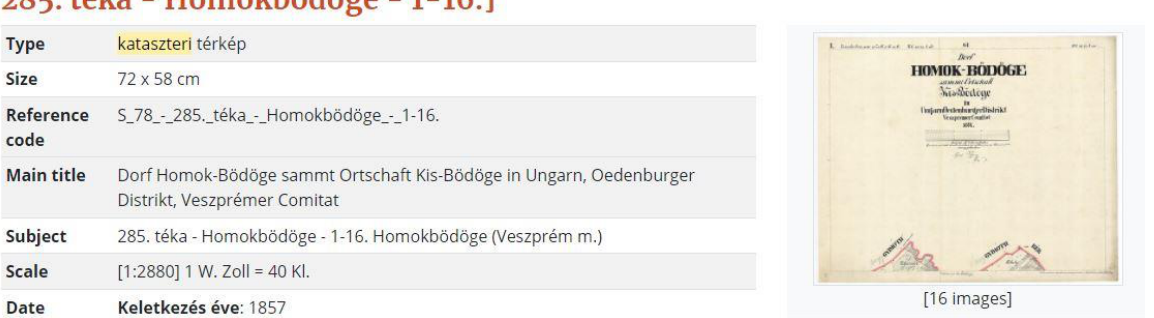
Figure 8. Cadastral map sheet in Hungaricana described by metadata elements of Dublin Core [66].